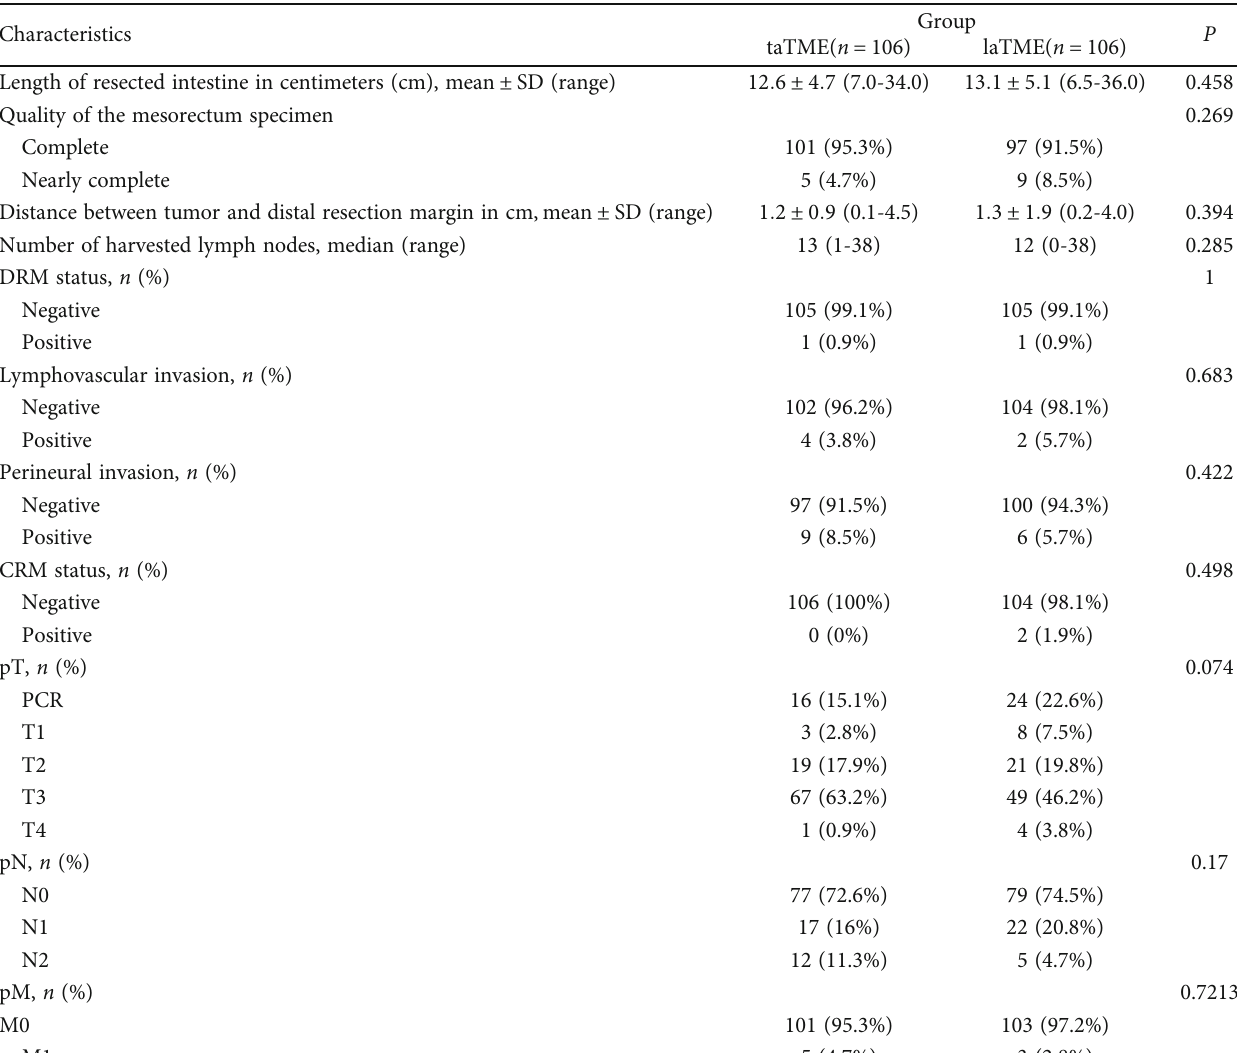
Table 3: Pathological